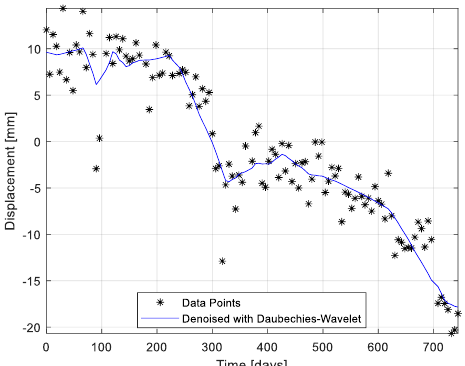
Figure 6. Original displacement time series of PS 2 (black stars) and the de-noised signal